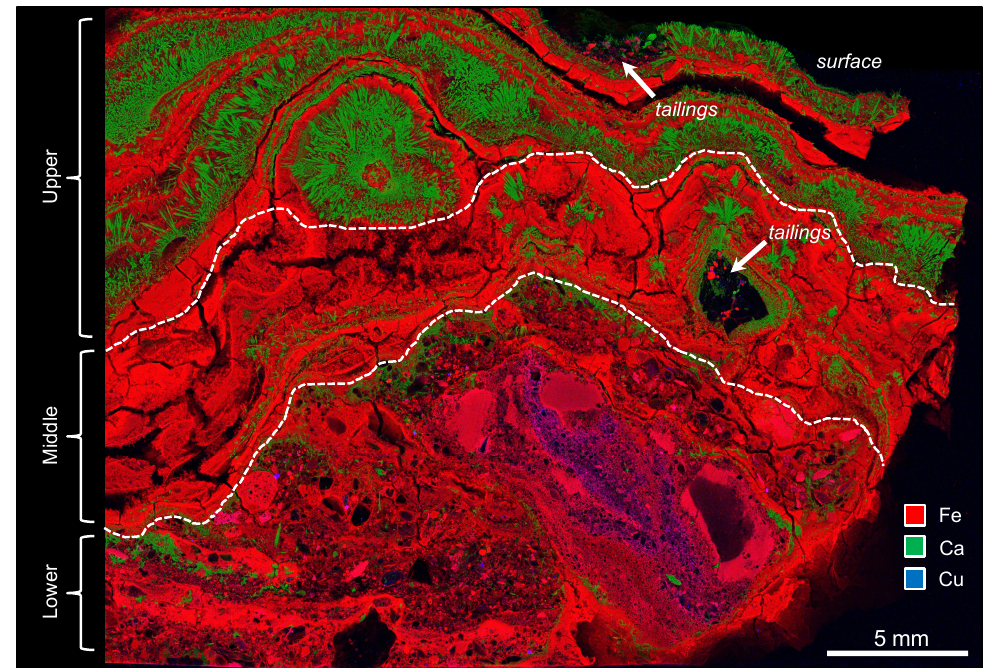
Figure 6. An X-ray fluorescence microscopy (XFM) map of the resin-embedded TIF showing the distribution of Fe, Ca, and Cu. The lower, middle, and upper regions are distinguished by the dashed line. Although tailing particles primarily occurred at the bottom, there also appeared to be accumulations on the ‘surface’ of the TIF. Note that the cleat-like fractures are an artifact of sample